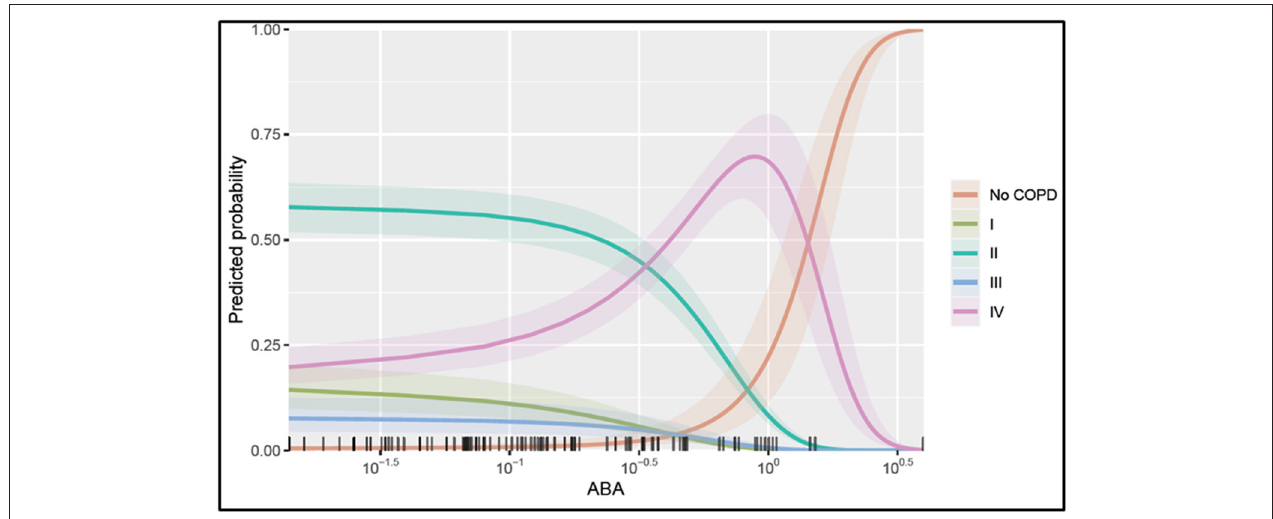
FIGURE 5 | Probability of being in one of the COPD stages over serum ABA levels. The plotted values were calculated assuming an average individual in the sample that is conditional on the mean value of the other covariates (condition in a patient aged 65, a CRP value at 10 0.83 , and adipsin value at 10 6.27 ) and their 95% confidence interval of the prediction. The rug at the plot’s bottom margin represents the data frequency used in the analysis. The statistical modeling was performed using R